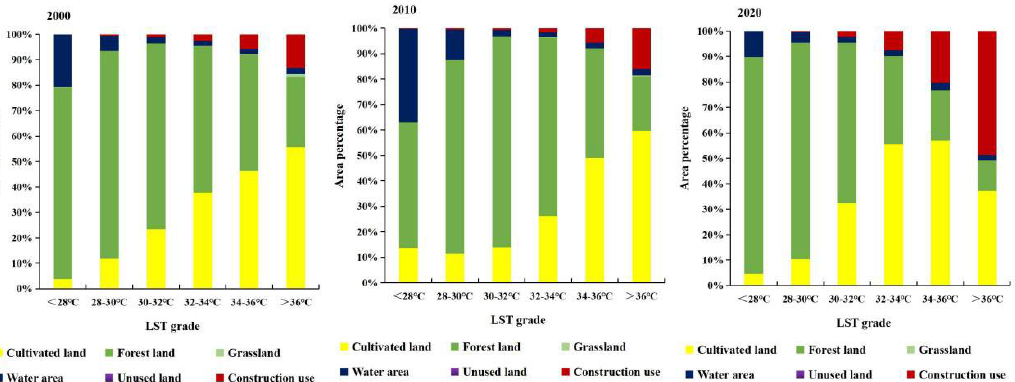
Figure 8. Proportion of different land use types for each LST grade during consecutive periods from 2000 to 2020 (represented by the starting year 2000, the middle year 2010, and the end year 2020). Then, the area proportion of each land use type and LST mean values of each county were calculated. By area ratio interval of 10%, the average value of LST of different land